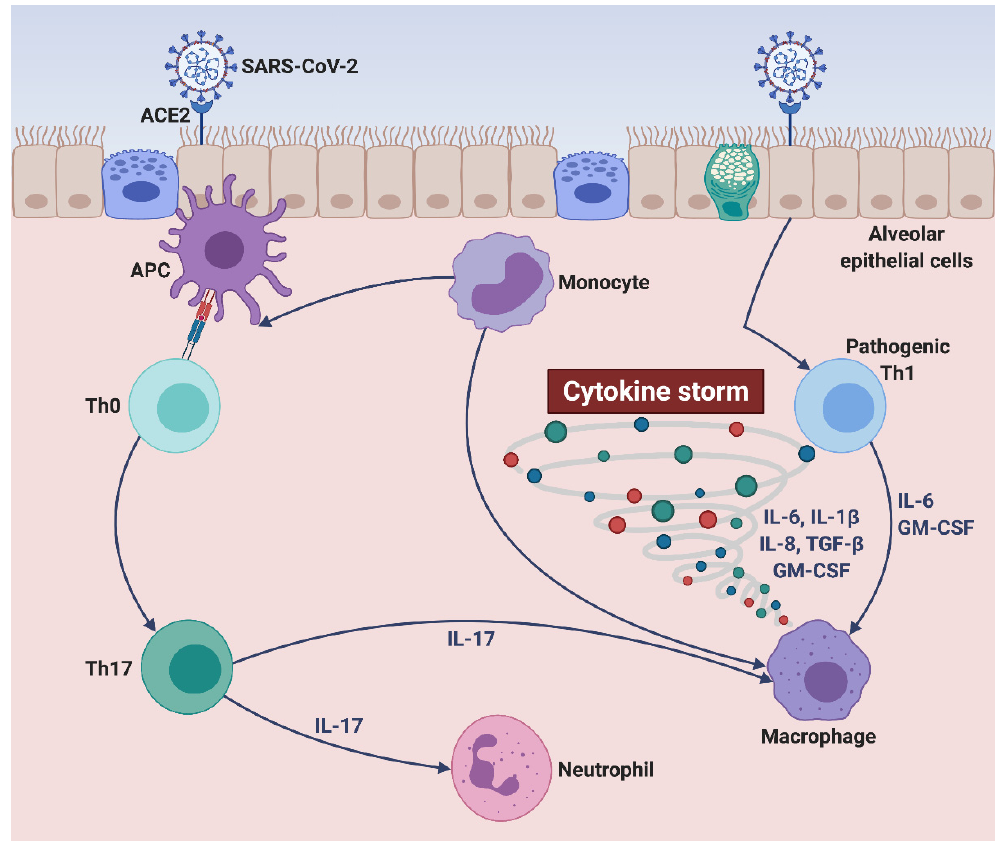
Figure 1. SARS-CoV-2-induced cytokine storm. SARS-CoV-2 targets alveolar epithelial cells, binds to their ACE2 receptors, and penetrates inside lung tissue, thus reaching subepithelial antigen-presenting cells. The latter can drive the differentiation of unpolarized naïve T cells into mature Th17 lymphocytes producing IL-17, leading to neutrophil recruitment and macrophage activation. Moreover, upon their interactions with SARS-CoV-2, infected alveolar epithelial cells can trigger the activation of pathogenic Th1 cells and monocytes/macrophages, which release large quantities of proinflammatory cytokines (IL-6, GM-CSF, IL-1 β , TGF- β ) and chemokines (IL-8). Within such a cytokine/chemokine milieu (cytokine storm), monocytes can undergo further cellular differentiation towards either alveolar macrophage phenotype or antigen-presenting cell lineage. This original figure was created by the authors using BioRender.com. SARS-CoV-2: severe acute respiratory syndrome coronavirus-2; ACE2: angiotensin-converting enzyme 2; APC: antigen-presenting cell; Th0: unpolarized naïve T helper cell; Th1: T helper 1 cell; Th17: T helper 17 cell; IL-1 β : interleukin-1 β ; IL-6: interleukin-6; IL-8: interleukin-8; IL-17: interleukin-17; GM-CSF: granulocyte-macrophage colony-stimulating factor; TGF- β : transforming growth factor- β .